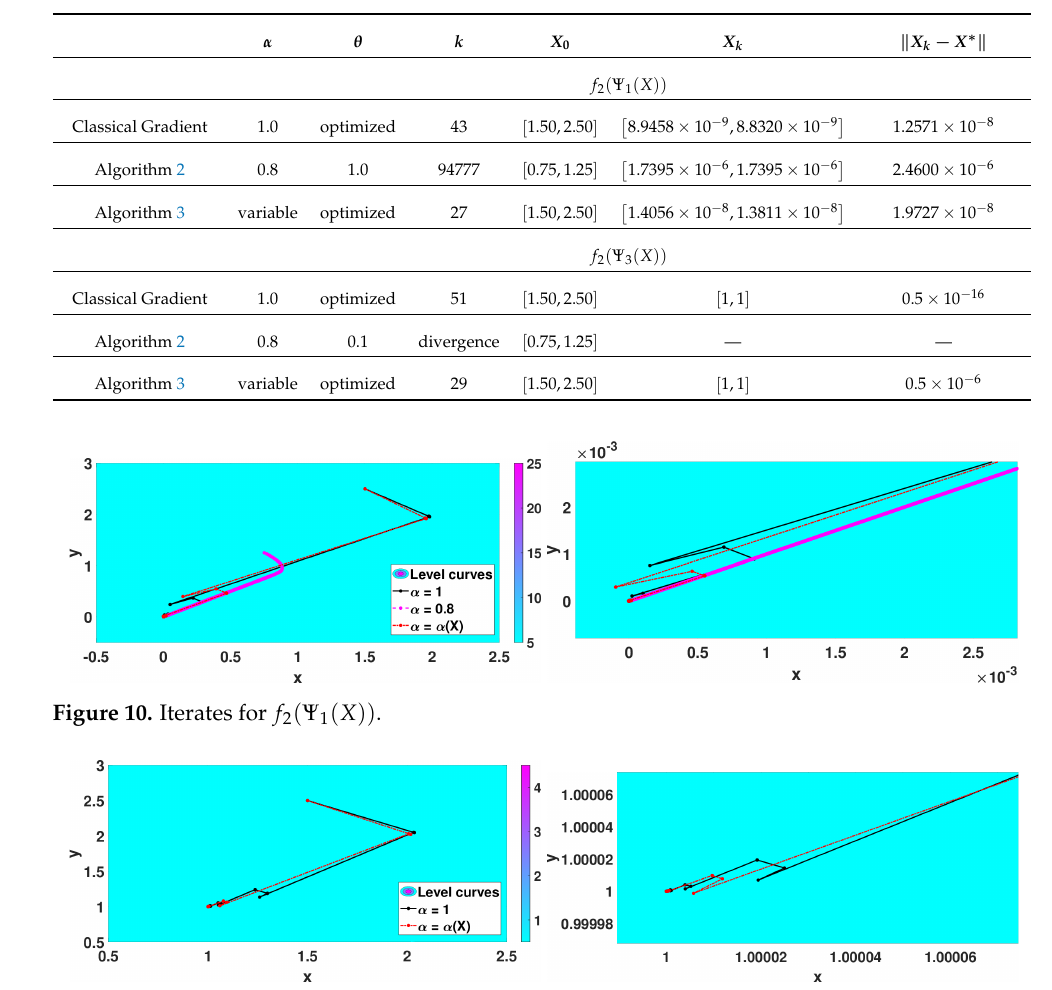
Figure 11. Iterates for f 2 ( Ψ 3 ( X ))